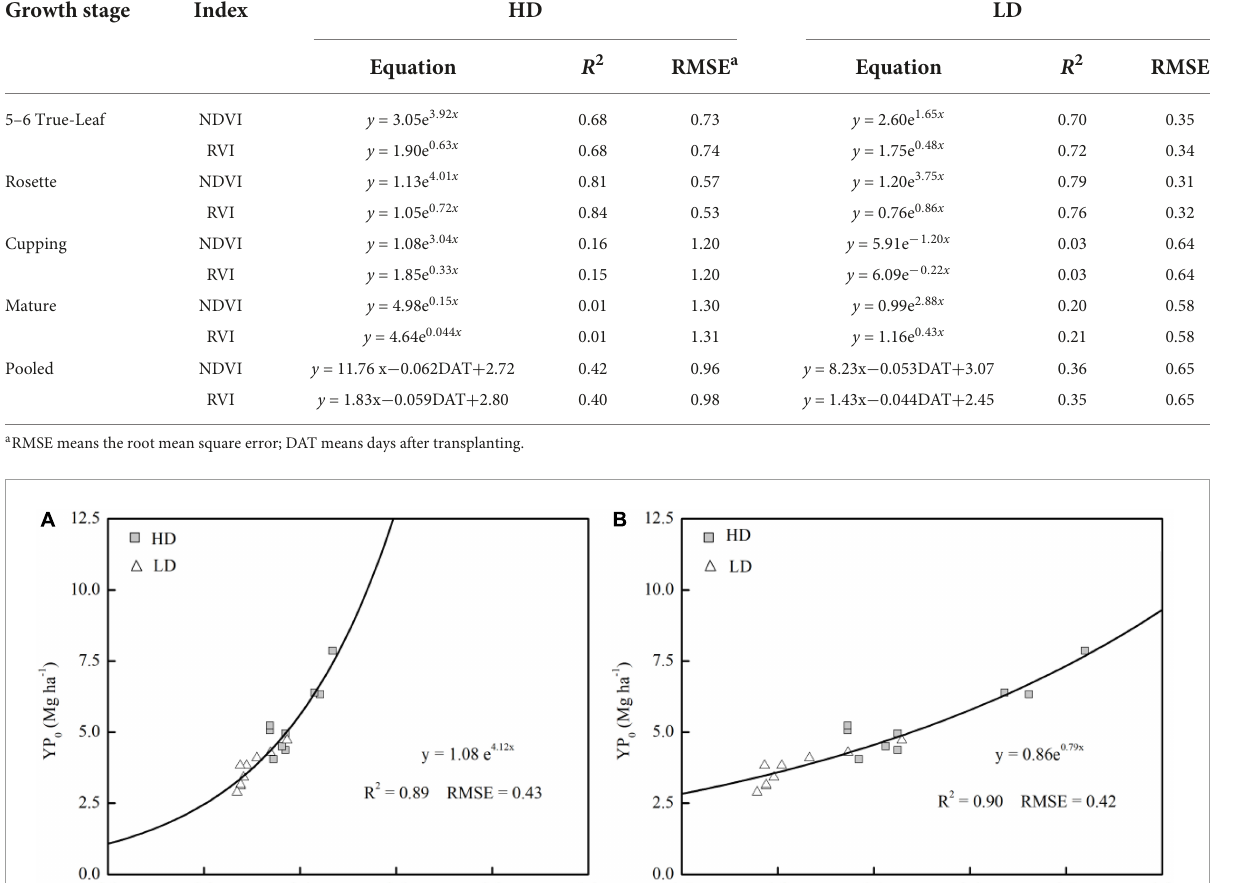
TABLE 3 Relationships between sensor-based measurements (NDVI and RVI) and yield potential without additional topdressing N application (YP 0 ) of bok choy at different densities of high density (HD) and low density (LD). Growth stage